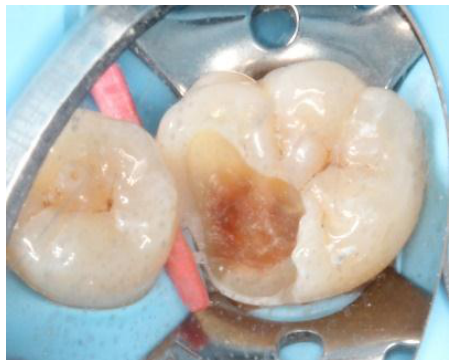
Figure 3. Caries removal under rubber dam isolation.